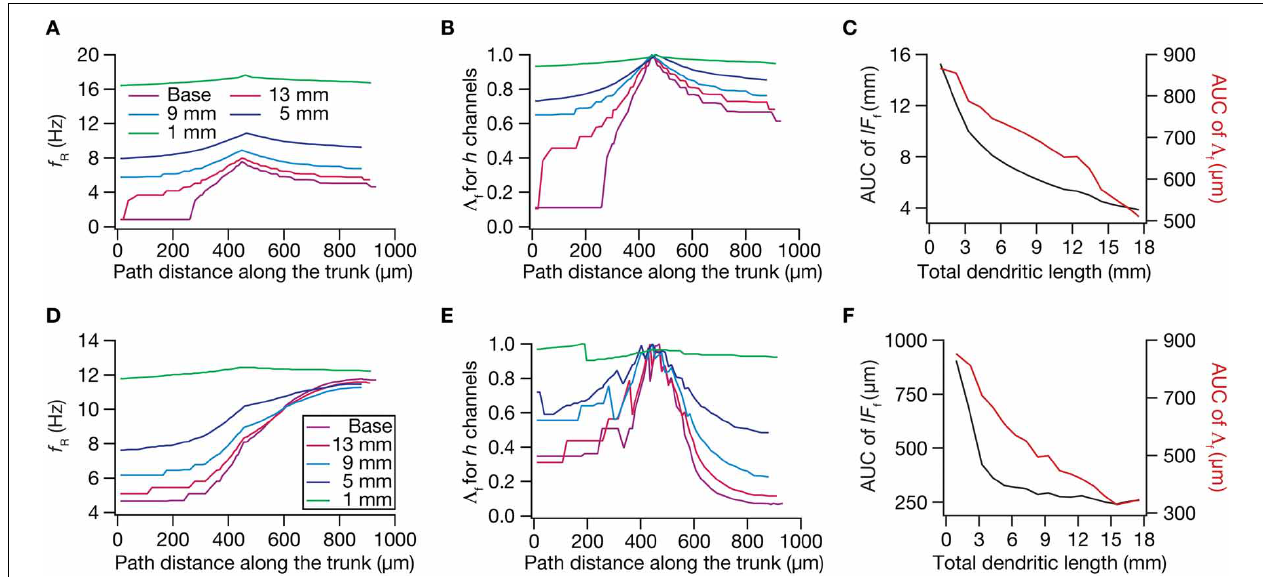
FIGURE 9 | Dendritic atrophy broadened the influence of a HCN conductance cluster on resonance frequency. The analyses presented in panels (A–C) correspond to passive neuronal models, and those presented in (D–F) correspond to models endowed with a physiologically relevant somatodendritic HCN-channel gradient. (A) Resonance frequency ( f R ), in different morphologies, measured in the presence of an HCN-channel cluster, incorporated at ∼ 450 μ m (path distance) location away from soma. (B) (cid:5) f , the normalized influence field for f R , along the somato-apical trunk for different morphologies. (C) Area under curve (AUC) for unnormalized (black) and normalized (red) influence field, plotted as functions of dendritic length of